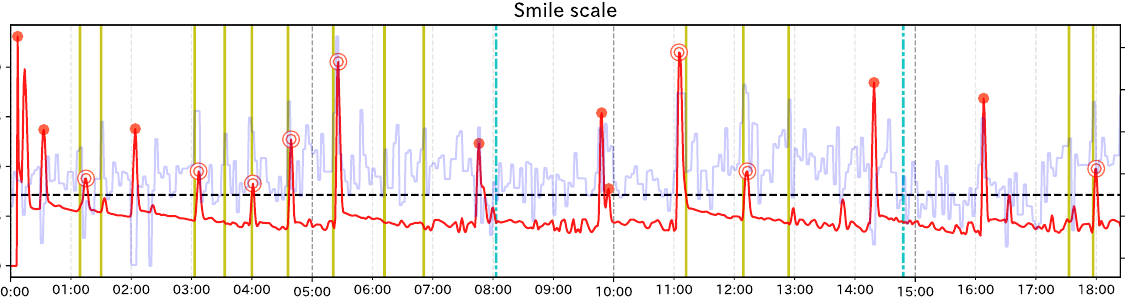
Figure 9. Graph of the change score for Smile scale (Subject C).